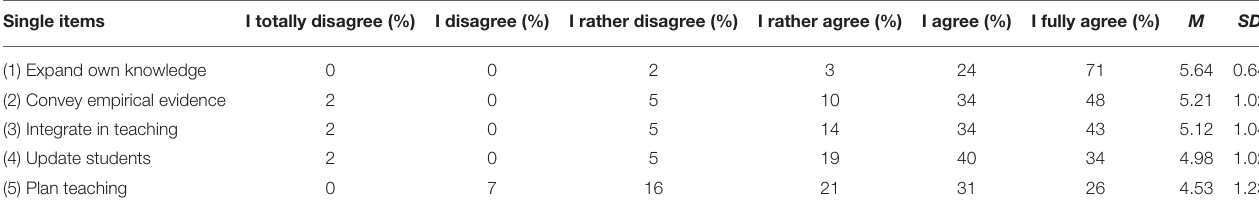
TABLE 5 | Descriptive statistics for purposes of use: percentage of nominations, mean scores (M), and Standard Deviation (SD) of the single items. Single